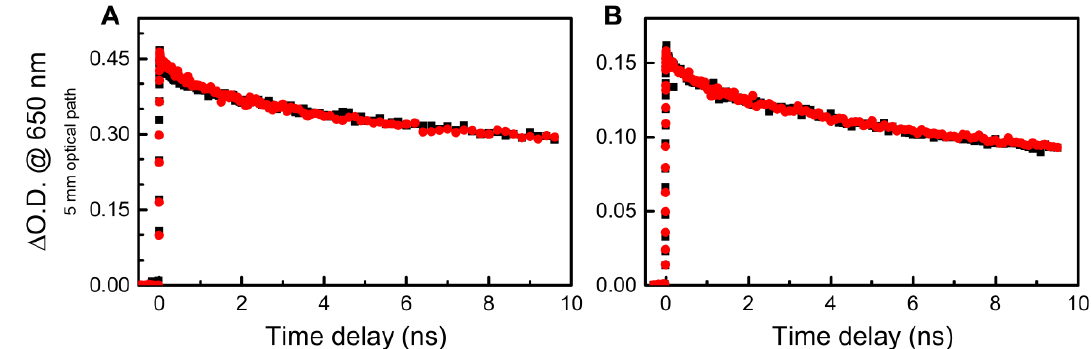
Figure 2. Kinetics of hydrated electrons within a few nanoseconds time range after a 5 ps electron pulse in water (black squares) and AuNPs suspensions containing 3 mM of gold atoms (red dots) prepared by borohydride ( A ) and citrate ( B ) reduction methods.